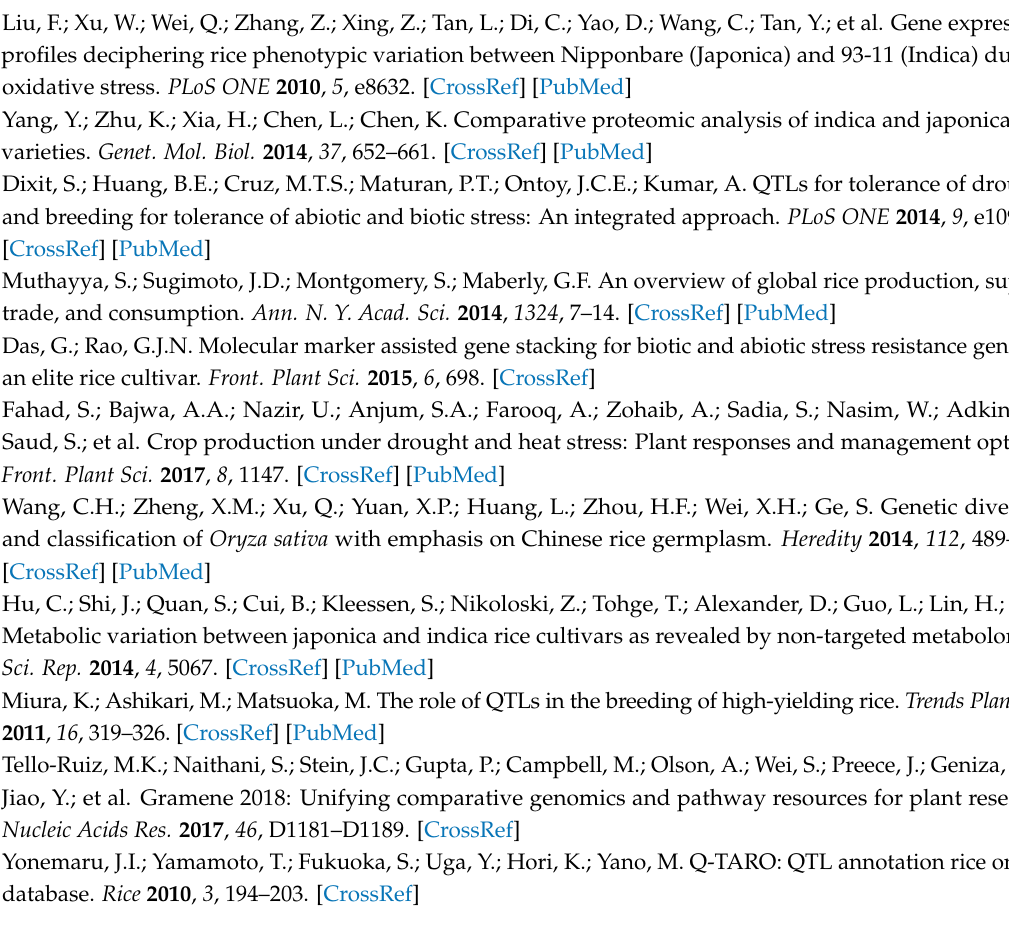
Table S2. Percentage of the lectin genes on the chromosomes (Sheet 1), total number and percentage of lectins (per family) resulting from tandem (Sheet 2) and segmental (Sheet 3) duplications for O. sativa spp. japonica. Table S3. Overview of all identified domain combinations containing lectin motifs in O. sativa spp. japonica (according to MSU and RAP-DB) and spp. indica. Numbers between brackets indicate the number of repeats. Table S4. Distribution of the different lectin families in QTL traits according to Q-TARO. Results for nematode resistance are according to Dimkpa et al. [15]. Every excel sheet represents one lectin family. Table S5. Overview of lectin sequences identified in O. sativa spp. japonica: chromosome location, distribution in QTL regions in general, as well as in QTLs related to abiotic and biotic stresses. Table S6. Overview of total number of QTLs related with resistance or tolerance traits (according to Q-TARO), number and percentage of QTLs containing lectins and distribution per lectin family. Table S7. Statistical analysis and p-values of the lectin distribution in QTL traits for all four categories. Table S8. Overview of the total number of QTLs related with morphological traits and physiological traits (according to Q-TARO), number and percentage of the QTLs containing lectins and distribution per lectin family. Figure S1. Segmental duplications in the genome of O. sativa spp. japonica. Figure S2. Venn diagram representing the appearance of the same lectins in more than one type of